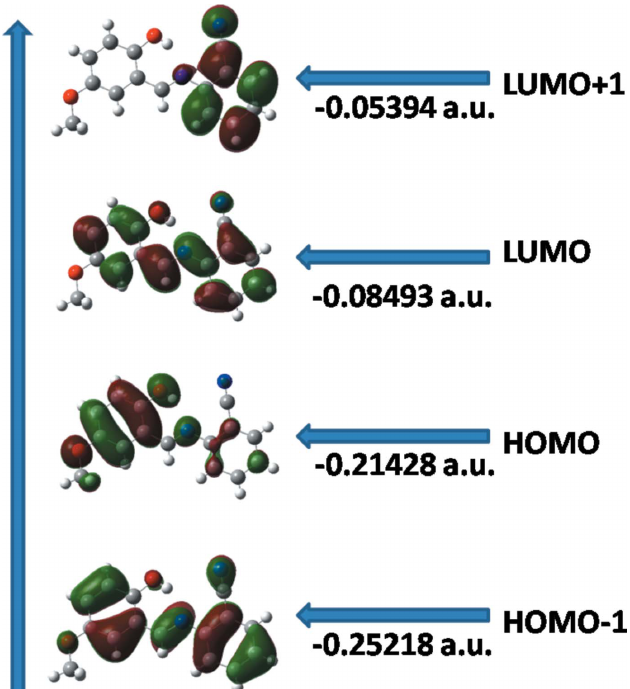
Figure 4 Molecular orbital surfaces and energies of HOMO (cid:4) 1, HOMO, LUMO and LUMO+1 for (I).